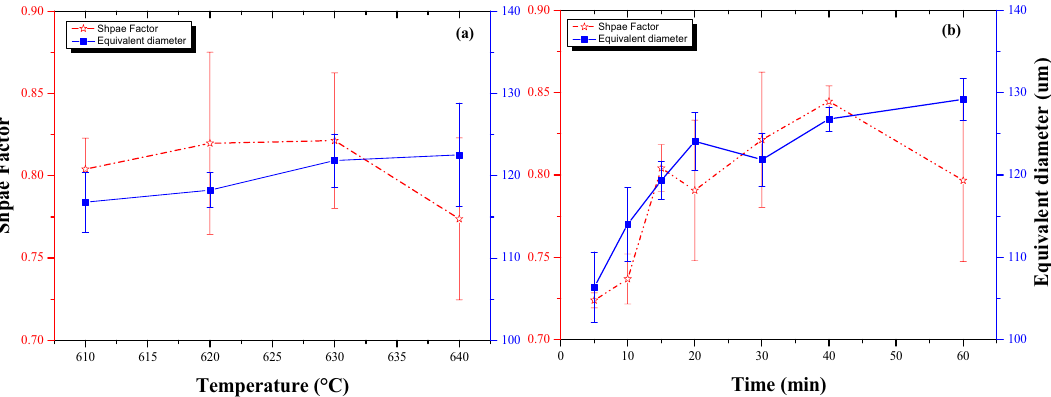
Figure 3. Shape factor (SF) and the equivalent diameter of the grains of Al–Fe–Cu based alloy with various temperatures and times. The imaginary line and the solid line represent Shape factor (SF) and Equivalent diameter, respectively. ( a ) Holding on 30 min; ( b ) heating at 630